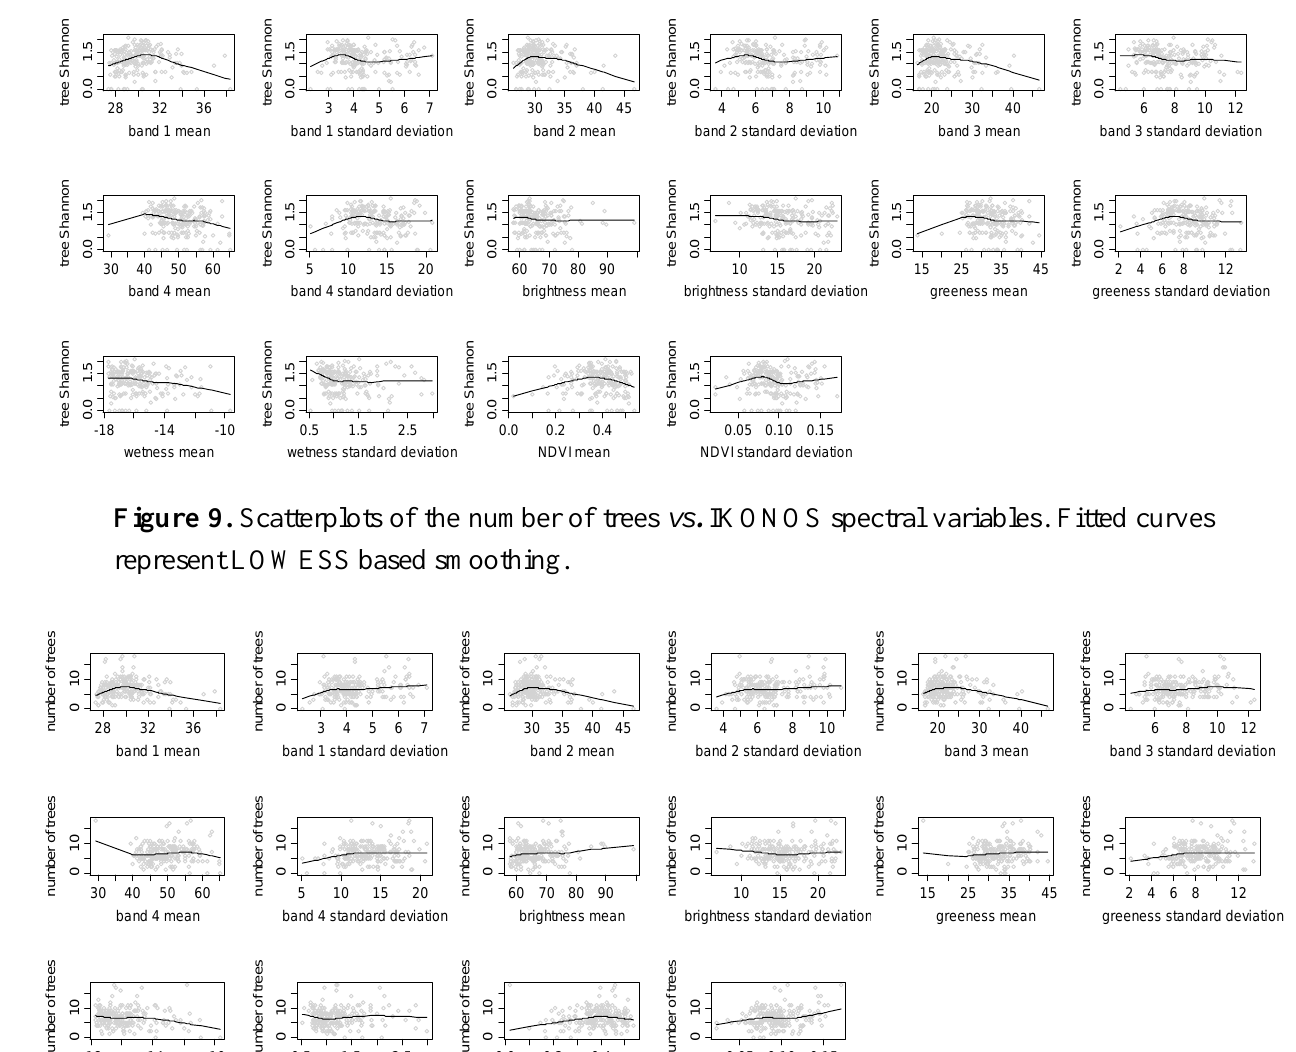
Figure 8. Scatterplots of tree Shannon diversity vs. IKONOS spectral variables. Fitted curves represent LOWESS based smoothing.